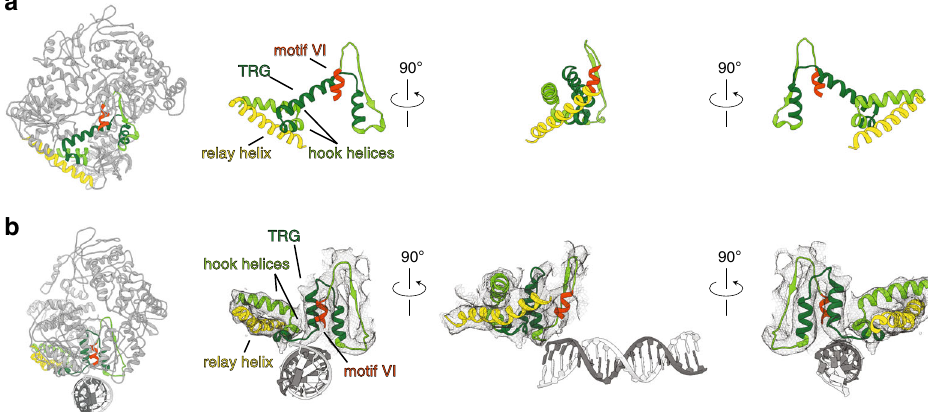
Fig. 5 Structural interlocking of the TRG motif, motif VI, and relay helix. a View of motif VI (red), TRG motif (dark green), hook helices (green), and relay helix (yellow) in the context of full-length nucleotide-free E. coli Mfd (left) and, for emphasis, as close-ups. b Similar views of DNA-bound E. coli Mfd highlighting conformational changes in this region The TRG helical hairpin closes and a bend is introduced into the relay